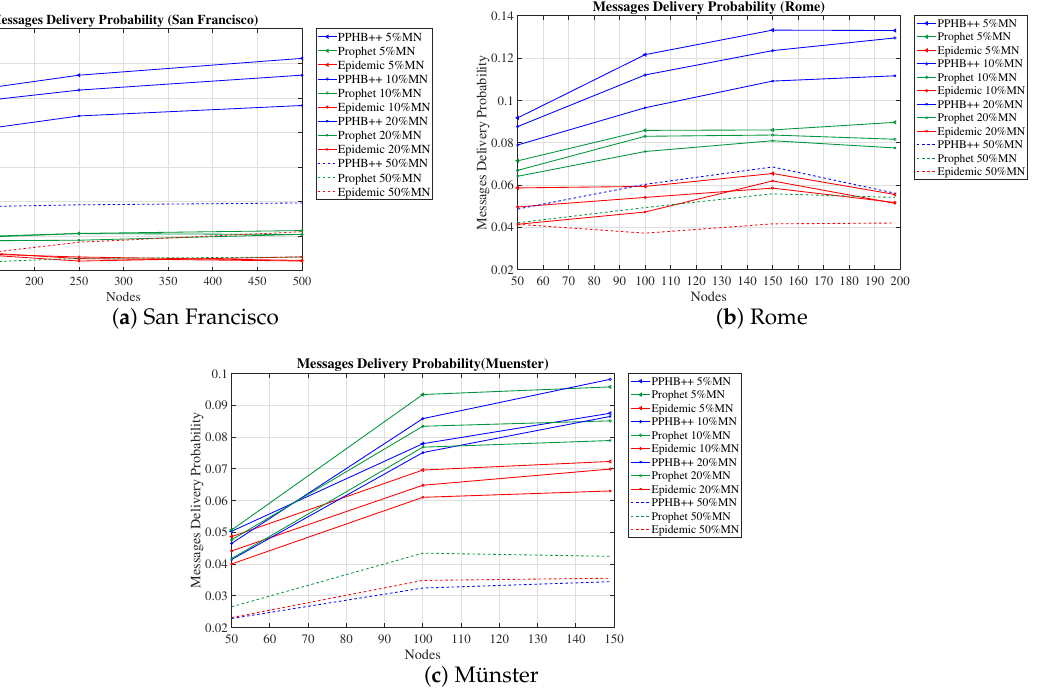
Figure 6. Message delivery probability (MDP) for the three cities of San Francisco, Rome, and Münster with the presence of malicious nodes in the network (the y-axis parameter is normalized to a scale between 0 and